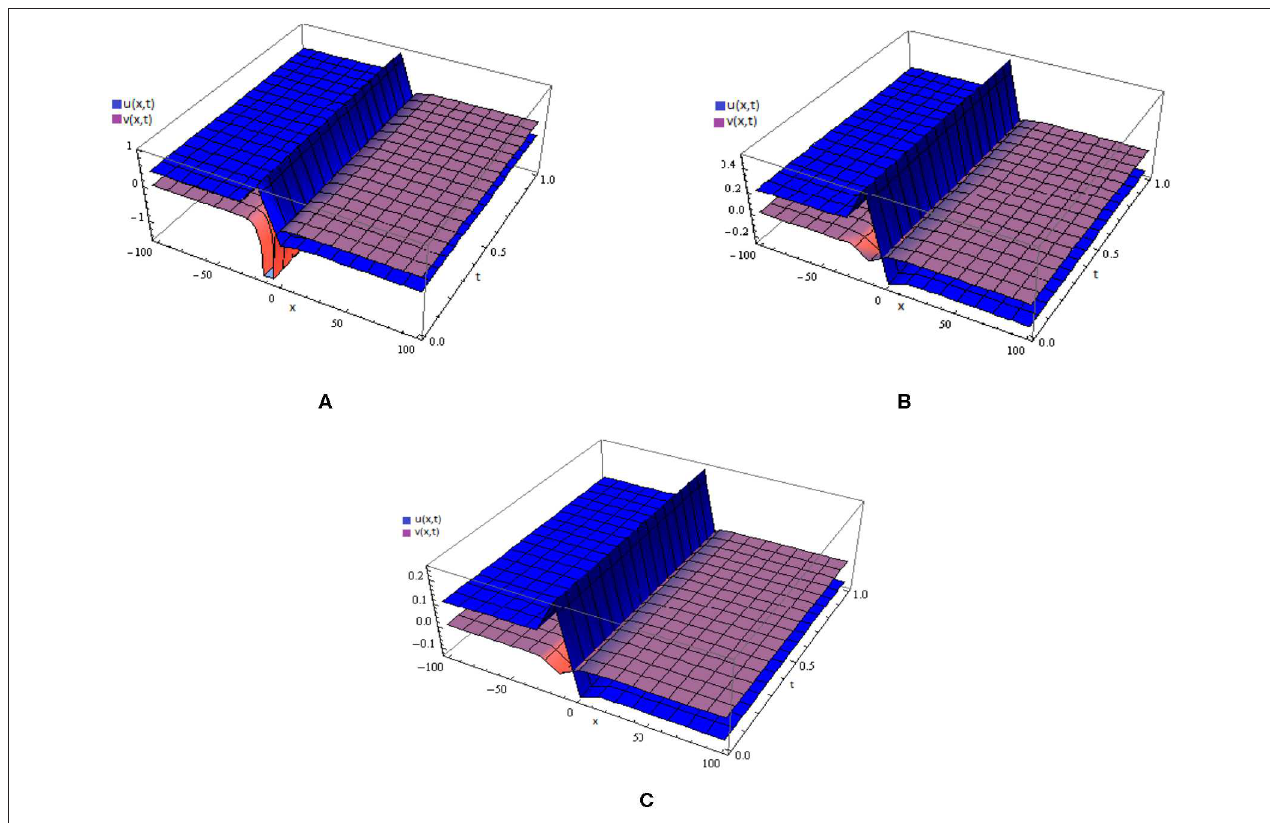
FIGURE 1 | (A) Coupled surface for WBK equation, (B) for MB equation, (C) for ALW equation at α